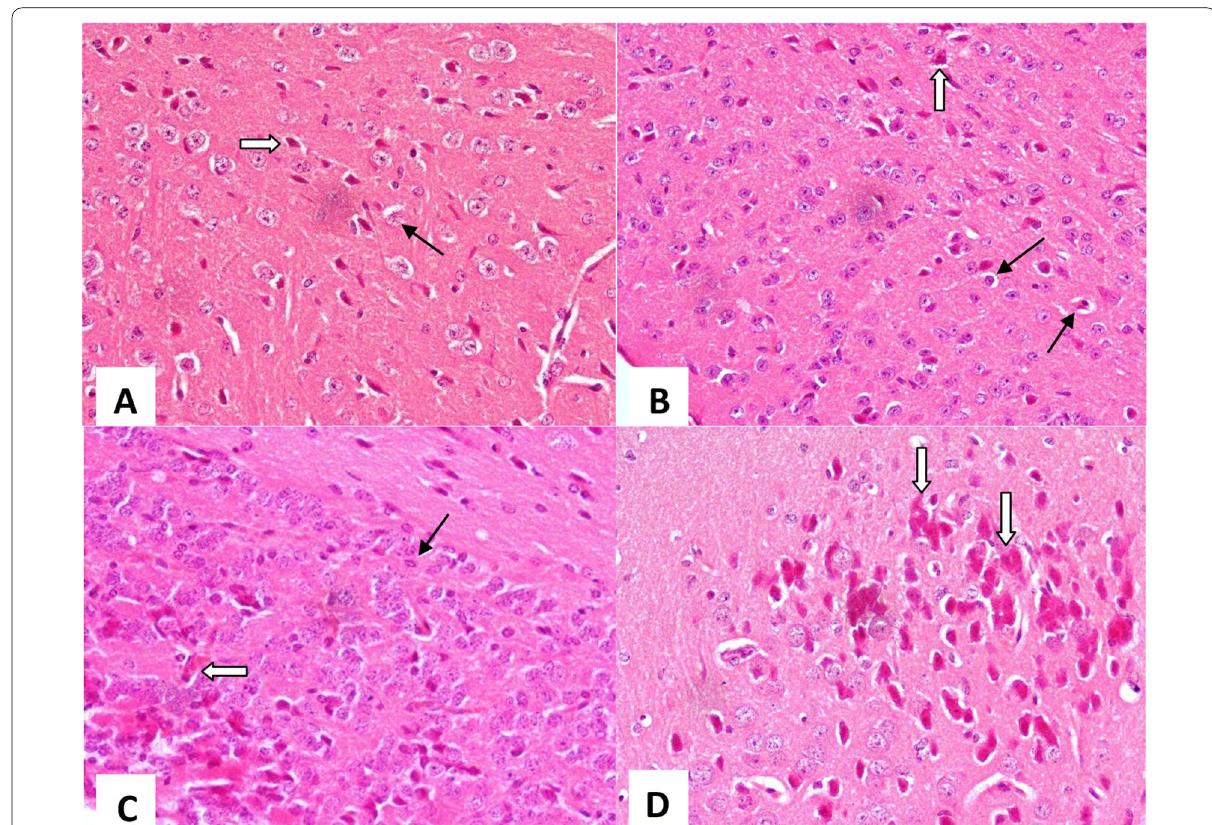
Fig. 8 A Brain tissue of mice treated with ( l -dopa COF PQ) showing numerous pigmented pyramidal neuronal cells (white arrow) among + + several other oligodendroglial cells (black arrow). B Brain tissue of mice treated with (L COF PQ) showing restored prominent cellularity with + + numerous oligodendroglial cells (black arrows) with scattered pigmented pyramidal neuronal cells (white arrow). C Brain tissue of mice treated with ( l -dopa COF PQ) showing cellular, organized Purkinje cell layer (black arrow) with scattered pigmented neuronal cells (white arrow). D Brain + + tissue of mice treated with ( l -dopa COF PQ) showing restored marked pigmentation within numerous neuronal pyramidal pigmented cells + + (white arrows) (H&E